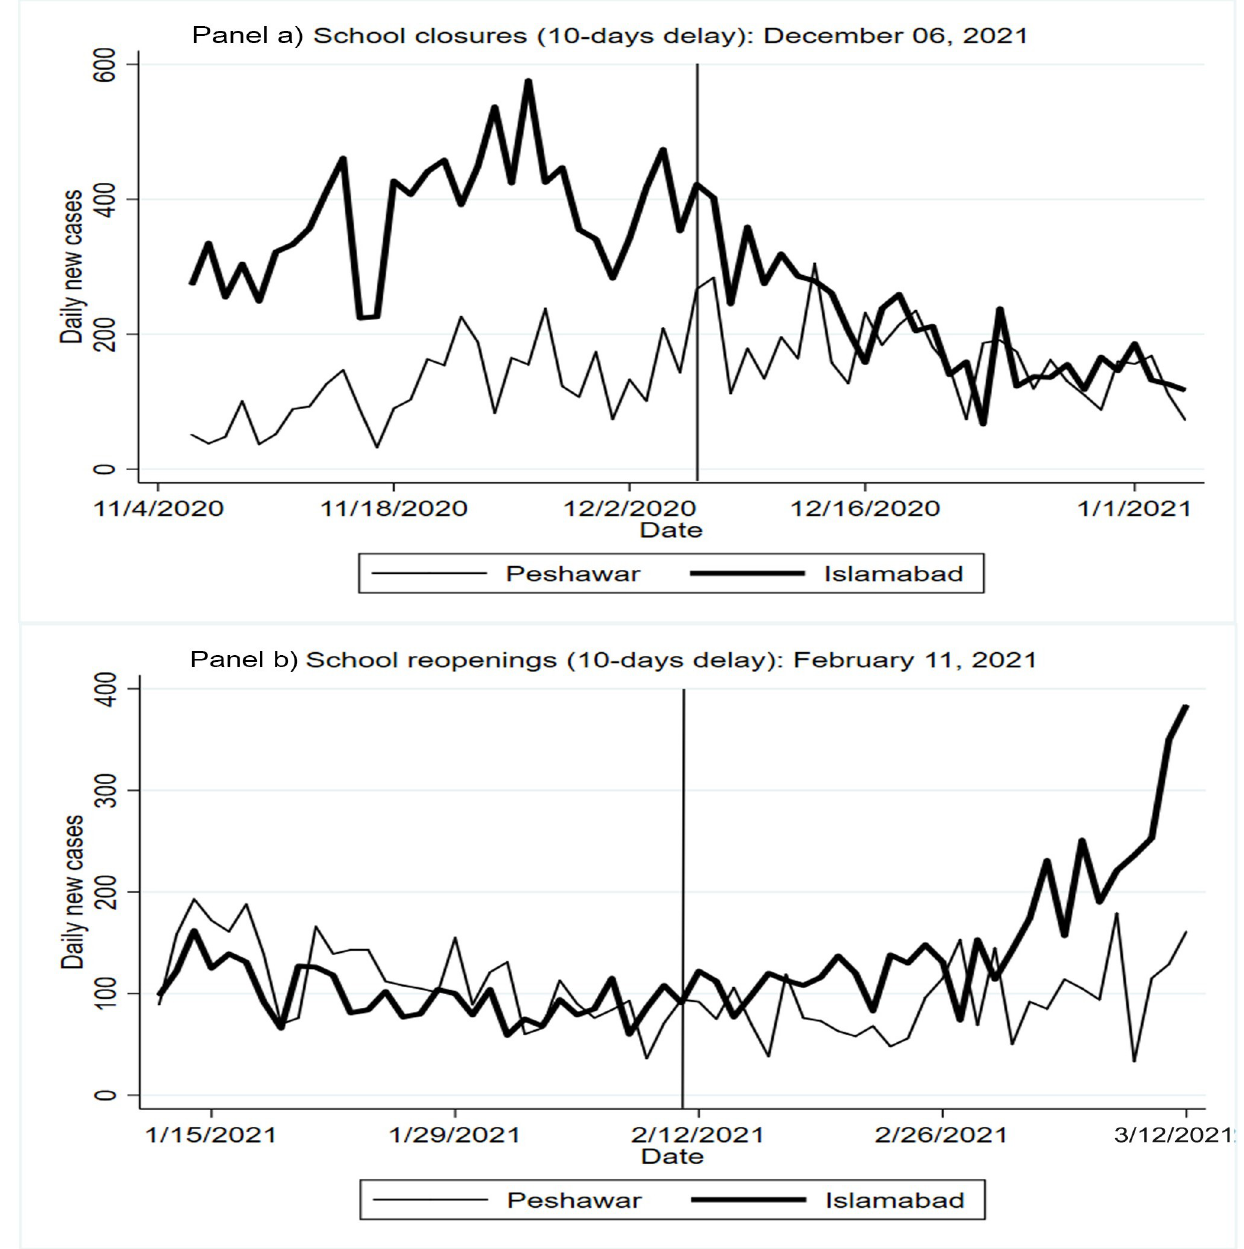
Fig 3. Daily COVID-19 cases in Islamabad and Peshawar pre- and post- school closure and school re-opening